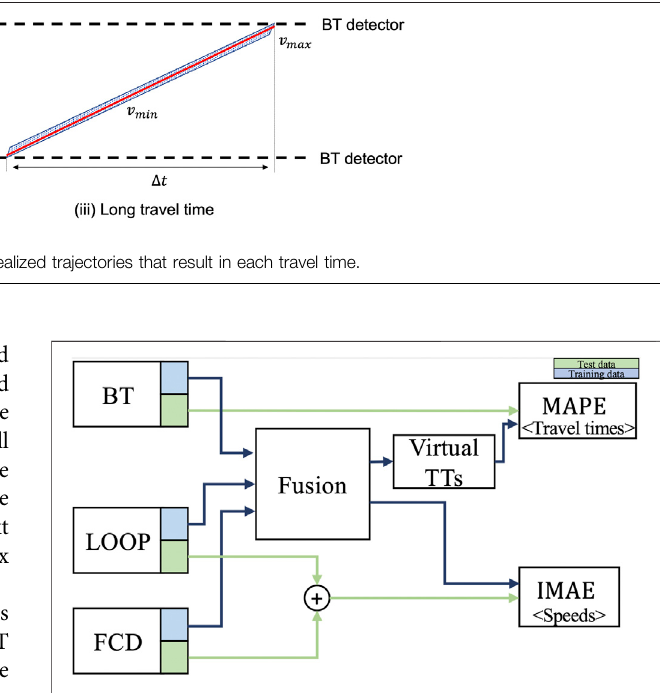
FIGURE4 | Flow ofinformation oftest and training set ofsensor data for fusion and quality